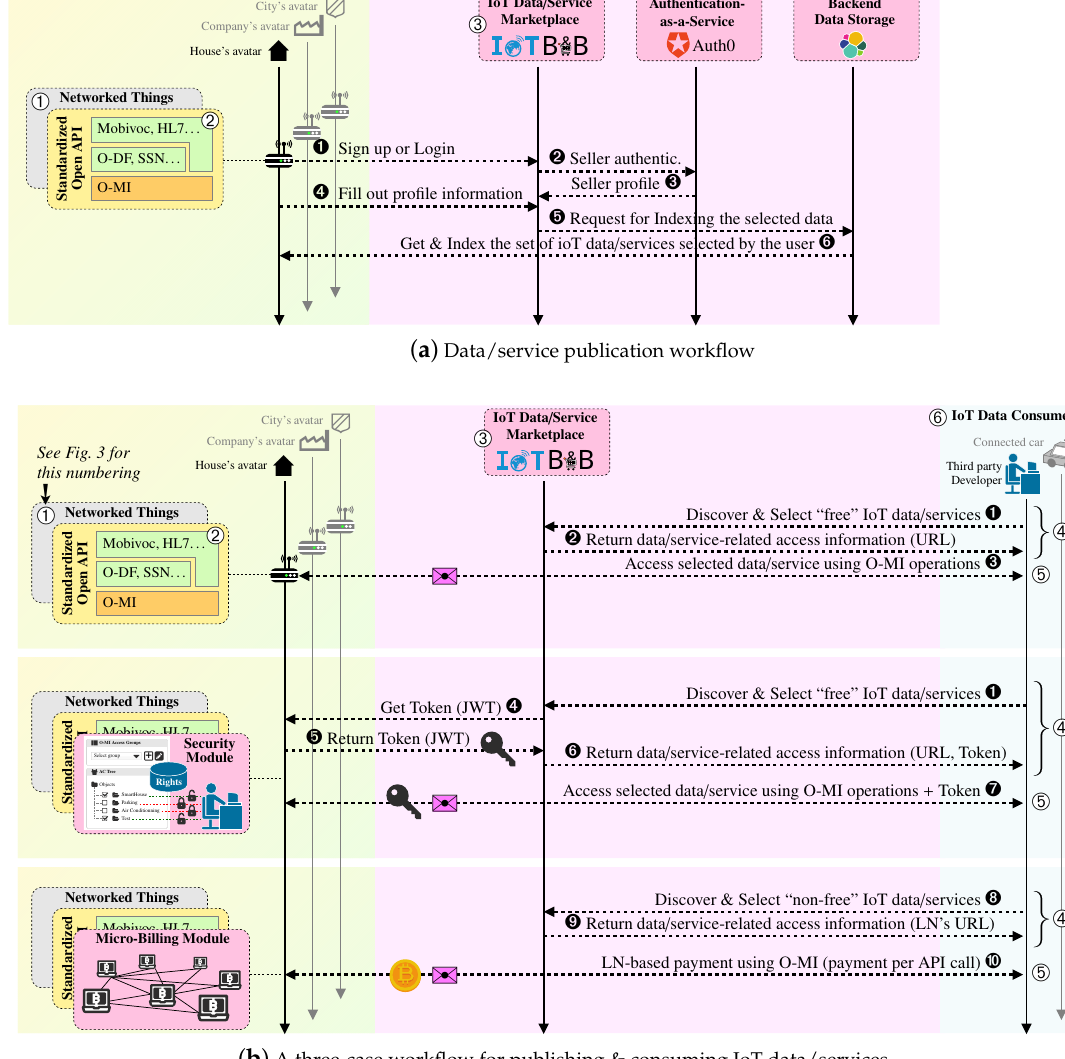
Figure 4. Data/Service consumers & publishers from the bIoTope ecosystem